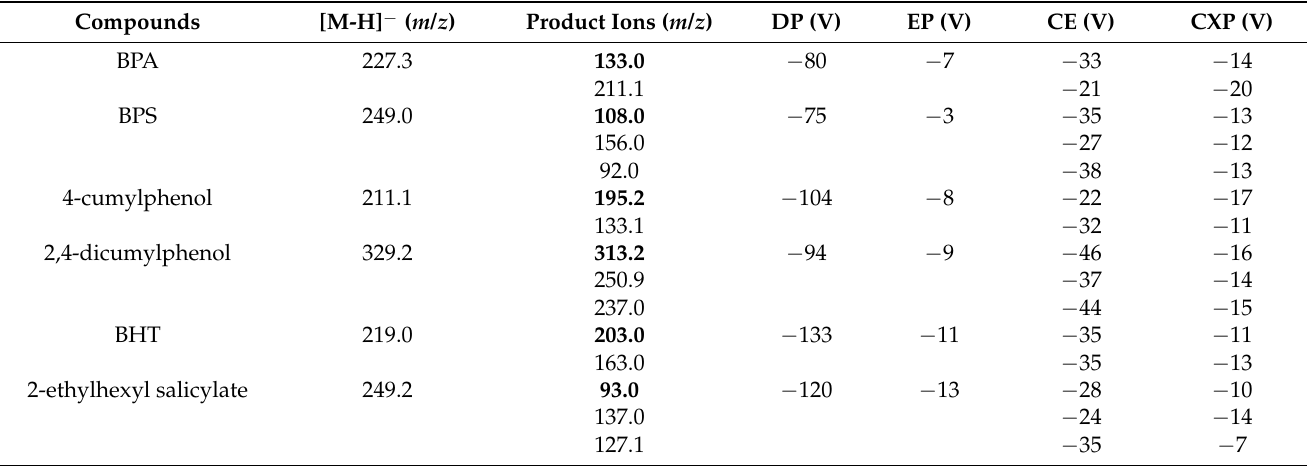
Table 2. Mixture 2 MRM parameters (DP: declustering potential; EP: entrance potential; CE: collision energy; CXP: collision exit potential). Quantifier ions are in